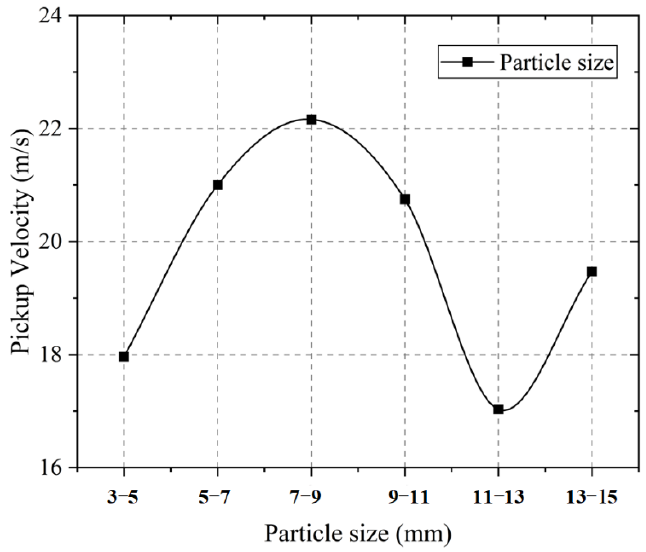
Figure 10. Function between particle size and pick-up velocity.